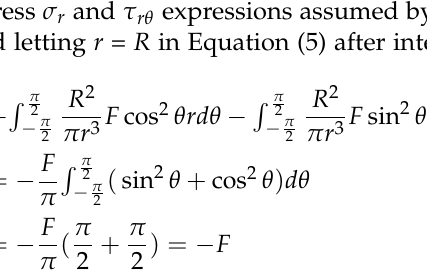
Figure 4. Figure 4. Microelement.